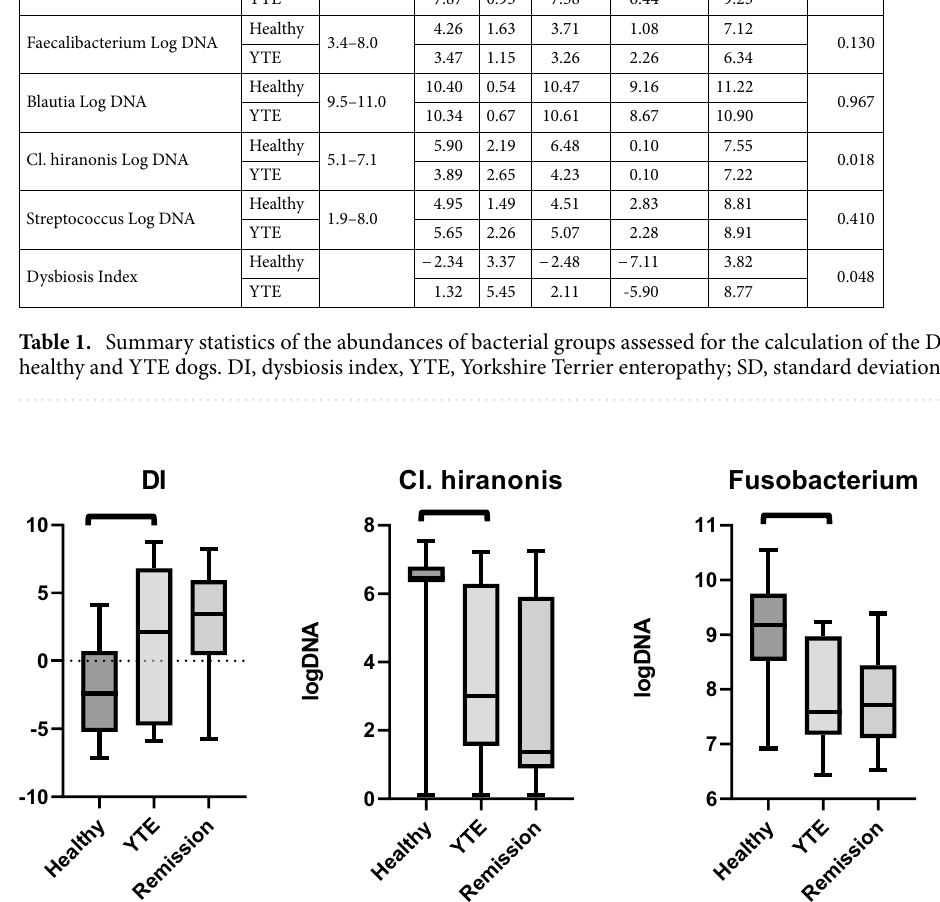
Figure 1. Box plots comparing the DI and the abundances of Cl. hiranonis and Fusobacterium in healthy controls, dogs with YTE, and dogs with YTE after achieving clinical remission. Square brackets are indicating significant differences between groups. Box plots represent the 25–75th percentile; the median is shown as the heavy dark horizontal line. Vertical lines extend to the minimum and maximum values. DI, dysbiosis index; YTE, Yorkshire Terrier